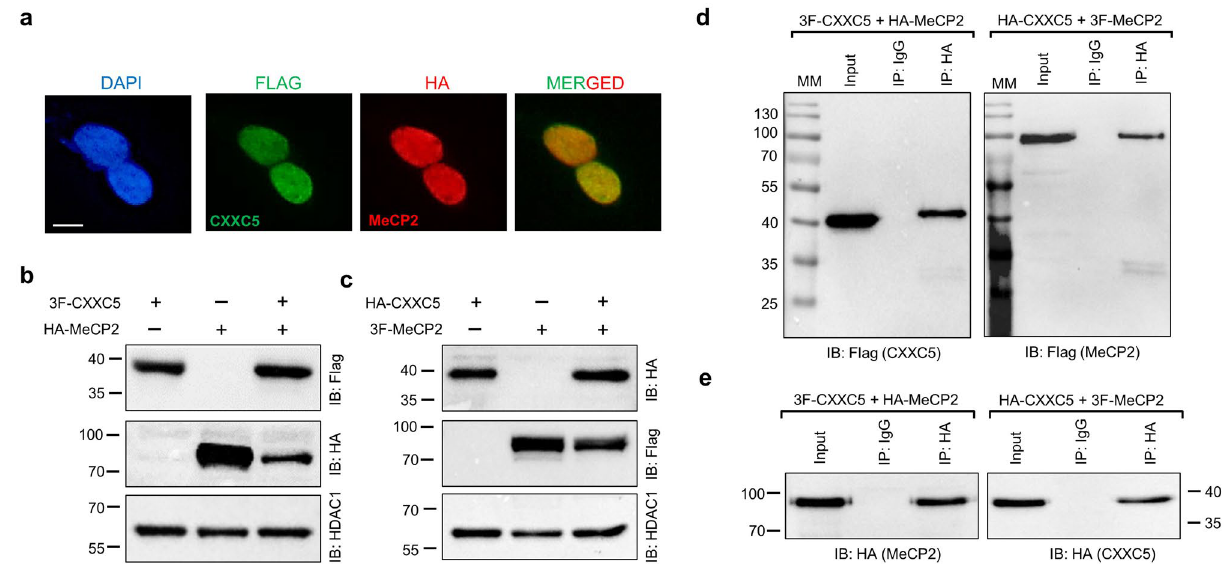
Figure 4. Interaction of CXXC5 and MeCP2. ( a ) The intracellular localization of CXXC5 and MeCP2 when co-synthesized is assessed with ICC of HEK293 cells transiently transfected for 48 h with the expression vector bearing the 3F-CXXC5 or the HA-MeCP2 cDNA. The Flag (green channel) or the HA (red channel) antibody was used to detect 3F-CXXC5 and HA-MeCP2, respectively. DAPI was used for DNA staining. The scale bar is 10 μm. ( b,c ) To examine the co-synthesis of CXXC5 and MeCP2, nuclear extracts of HEK293 cells transiently transfected with the expression vector bearing ( b ) the 3F-CXXC5 and/or the HA-MeCP2 or (c) HA-CXXC5 and/or the 3F-MeCP2 cDNA were subjected to WB analysis. Proteins were immunoblotted (IB) with the Flag or HA antibody. HDAC1 used as a loading control was probed with the HDAC1 antibody. ( d,e ) The nuclear extracts of HEK293 cells co-synthesizing 3F-CXXC5 and HA-MeCP2, or co-synthesizing HA-CXXC5 and 3F-MeCP2 were subjected to Co-IP using the HA antibody or the isotype-matched IgG followed by immunoblotting using ( d) the Flag or ( e ) the HA antibody. Molecular masses (MM) in kDa are post-translational modifications of the protein 52 . Immunoprecipitation of 3F-CXXC5 or 3F-MeCP2 with the HA antibody (Fig. 4d) in the presence of HA-MeCP2 or HA-CXXC5 in immunoprecipitants, respectively, (Fig. 4e) suggests that CXXC5 and MeCP2 are interacting partners. The interaction between the unmethylated CpG dinucleotide binder CXXC5 and the DNA methylation reader and histone modifier MeCP2 is perplexing and enticed us to further explore the feature of this interaction. To extend the verification that CXXC5 and MeCP2 are interacting partners, we carried out the proximity ligation assay (PLA). PLA used here utilizes species-specific secondary antibodies conjugated with distinct DNA primers. A hybridization step followed by circular DNA amplification with fluorescent probes to the conjugated DNA primers allows the visualization of proximity spots by fluorescence microscopy 53 . In transiently transfected HEK293 cells synthesizing HA-MeCP2 and/or 3F-CXXC5, the HA or the Flag antibody alone showed virtually no fluorescence signal in cells whereas prominent nuclear fluorescence signals were detectable when cells were